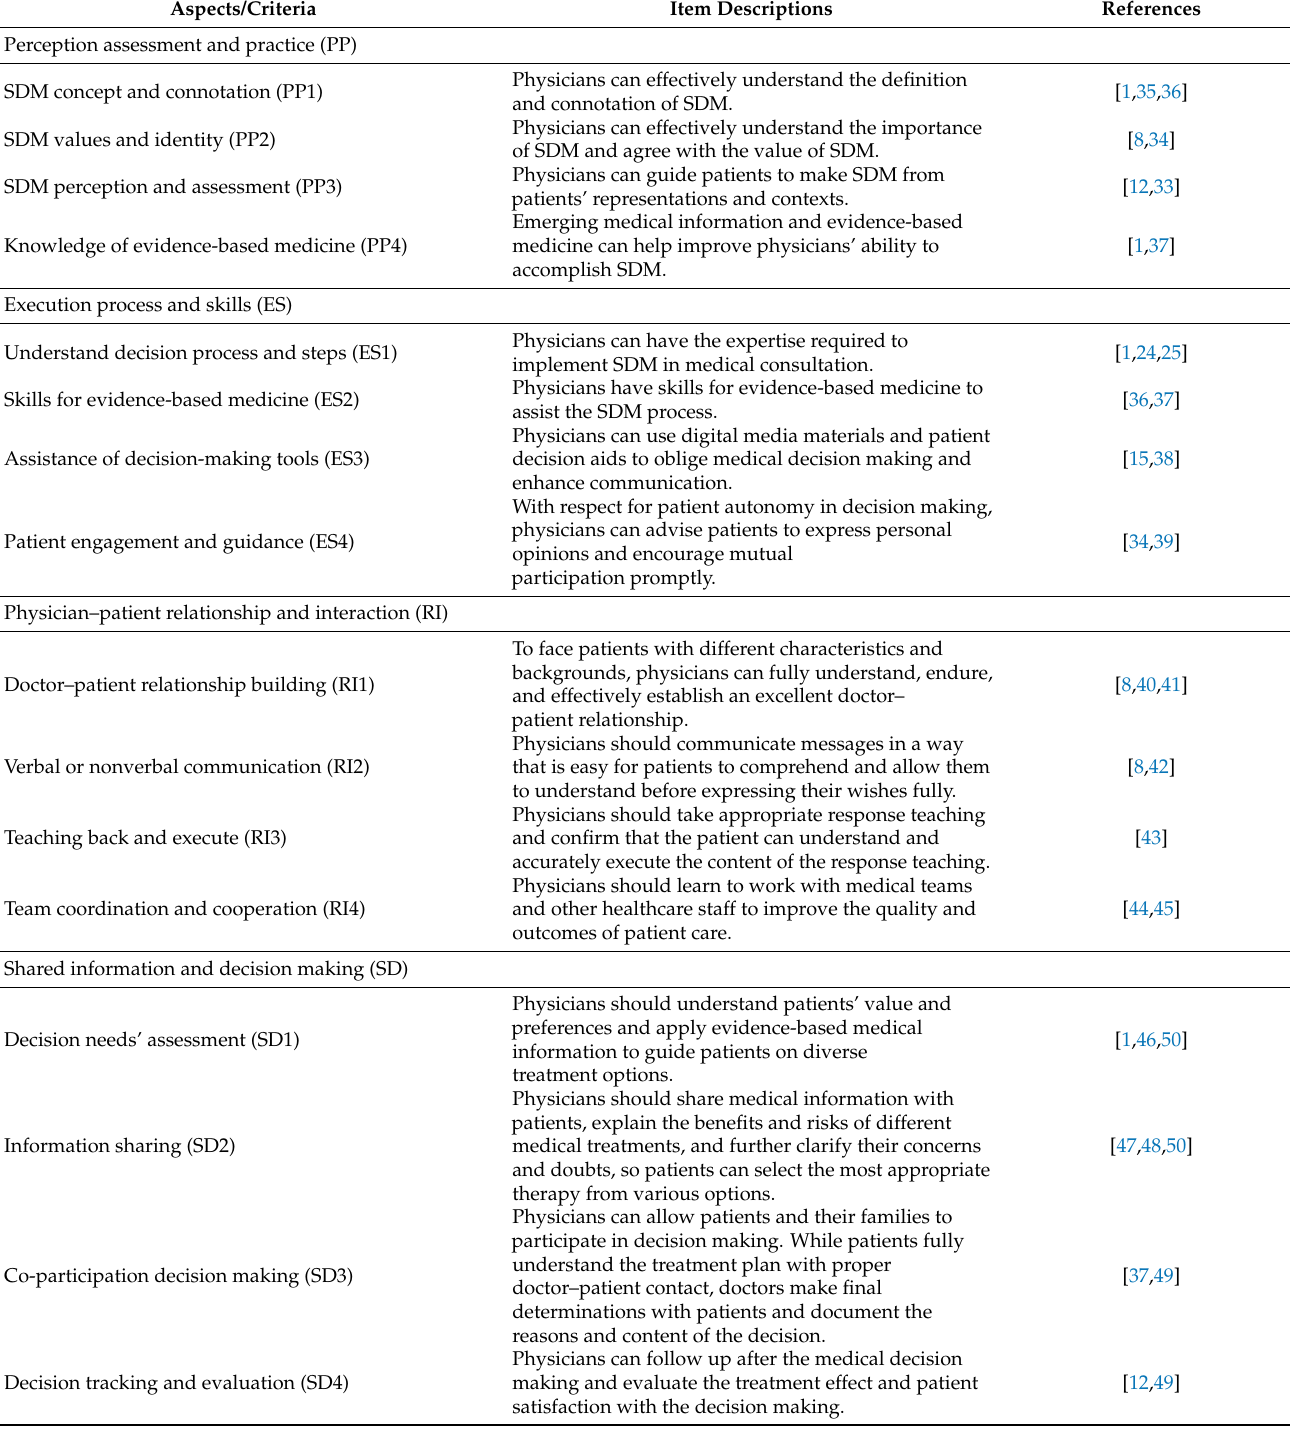
Table 1. The descriptions of aspects/criteria of SDM competency development for